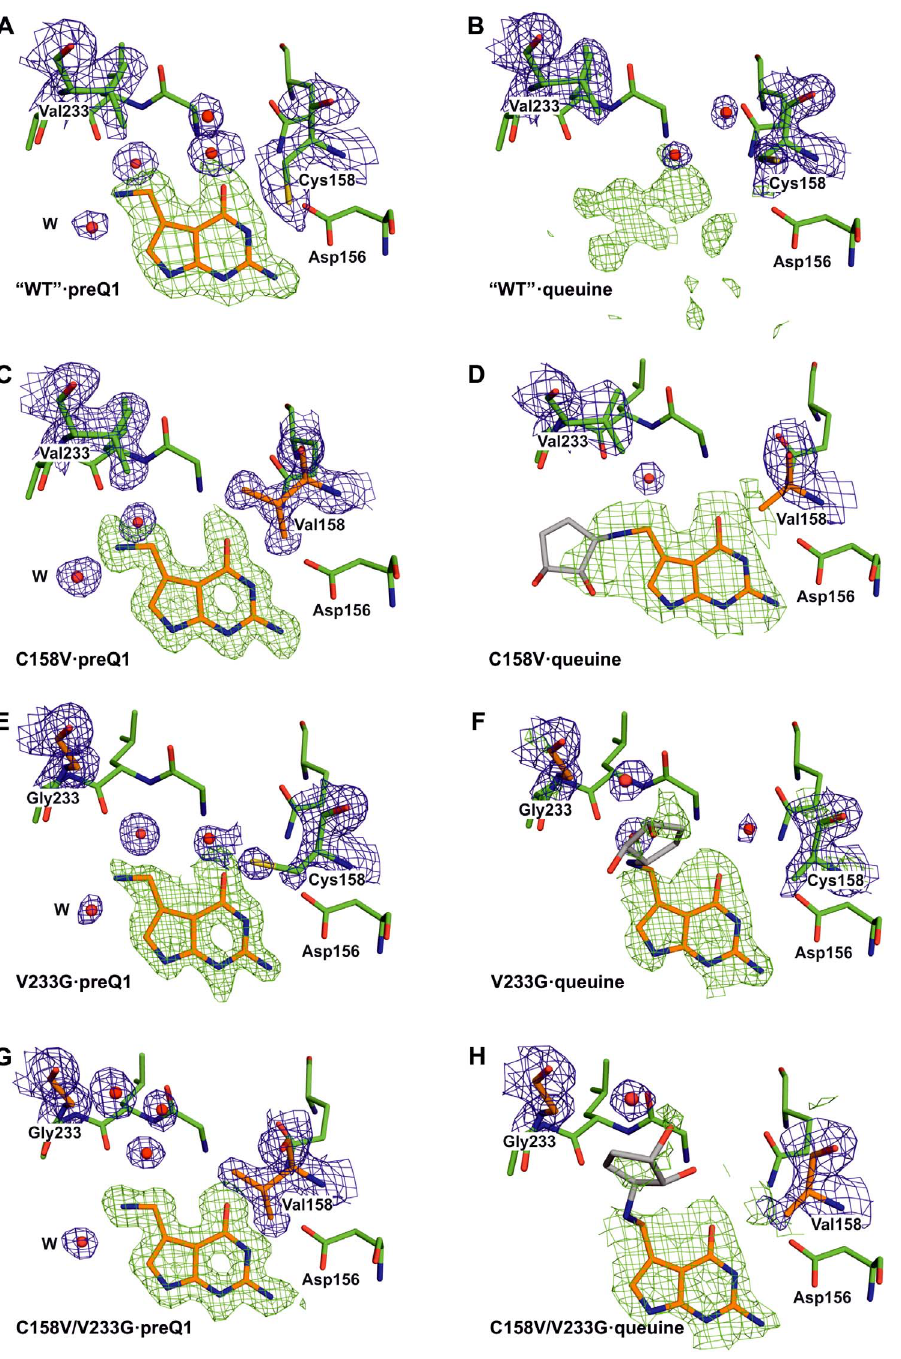
Figure 8. Crystal structures of Tgt variants in complex with preQ 1 or queuine: stick representation of substrate pockets. The respective Tgt variant plus the bound ligand are indicated in each sub-figure. Carbon atoms of original amino acids are coloured green, those of mutated amino acids as well as of the bound ligand orange. As the electron density assignable to the dihydroxy-cyclopentenyl moiety of queuine is poorly defined in all structures containing this ligand the coordinates of this moiety are not present in the respective structures deposited with the Protein Data Base. Accordingly, the conformations of the dihydroxy-cyclopentenyl shown in (D), (F) and (H) are tentative. To indicate this fact, the carbon atoms of this moiety are shown in grey. Selected water molecules are shown as red spheres. Electron density is shown for amino acid residues at positions 158 and 233 as well as for the ligand and for water molecules. The 2|F o |-|F c | electron density map contoured at a s level of 1.0 is coloured blue. The green density represents an |F o |-|F c | omit map contoured at 2.5 s . An overview of the crystal structures analysed in this study including nominal resolutions and PDB codes is given in Table S1.